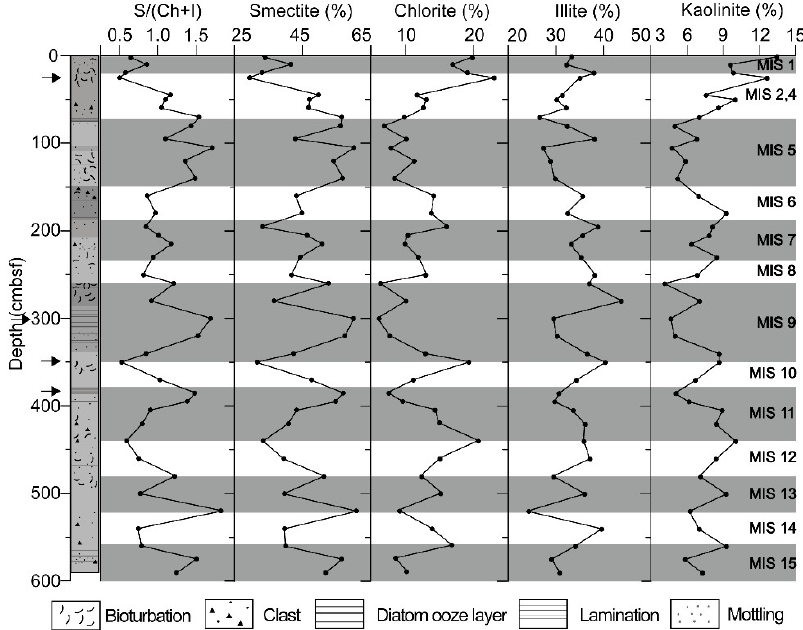
Figure 2. Sedimentary facies and contents of smectite, chlorite, illite, and kaolinite in sediment from core GC05-DP02 in southern Drake Passage. Marine Oxygen Isotope Stage (MIS) assignment following Lee et al. (2012) [15]. Arrows indicate the depth of TEM samples.